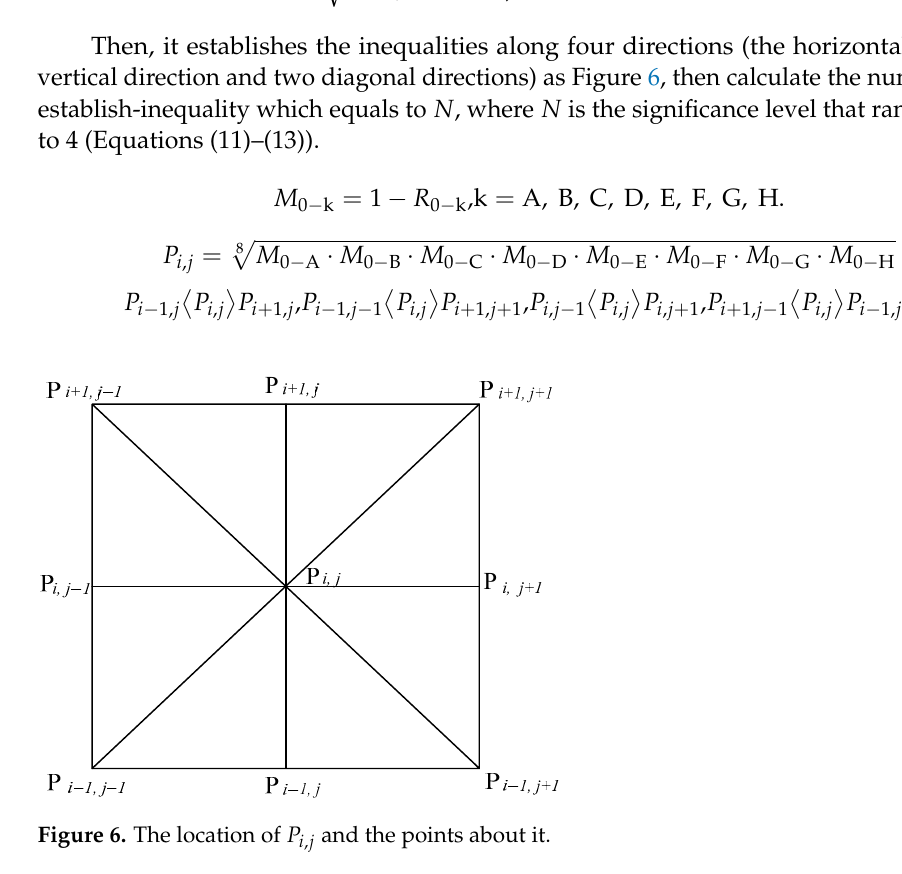
Figure 6. The location of , i j P and the points about it.